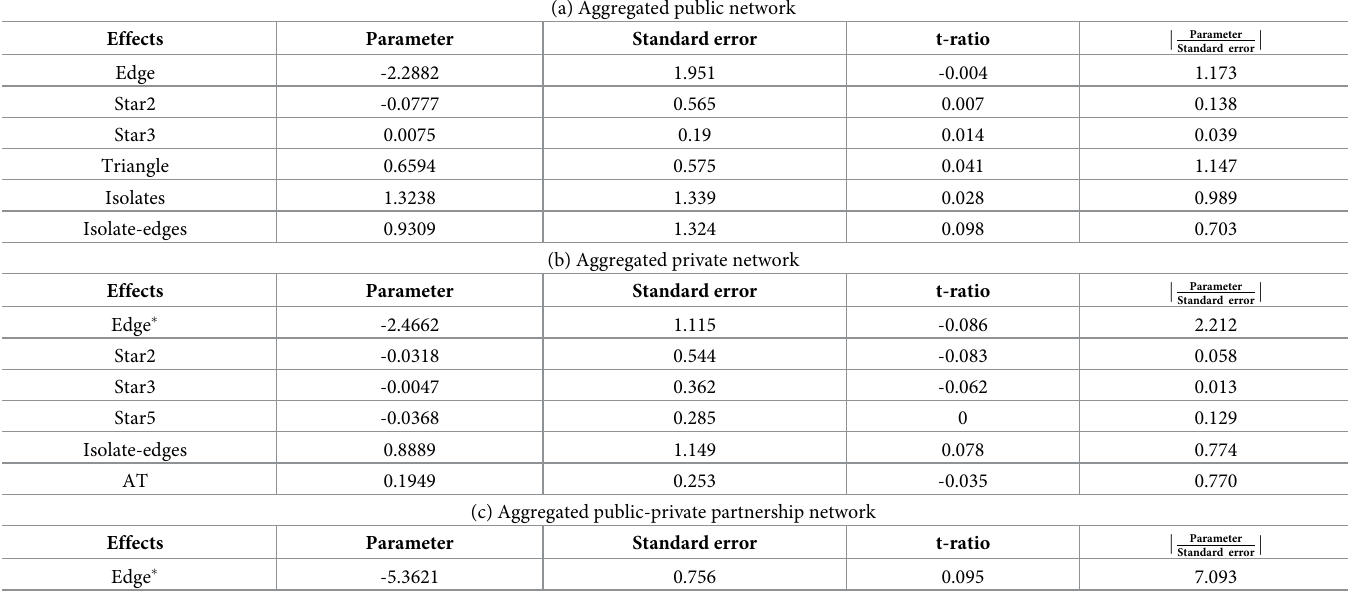
Table 6. The estimation results from the exponential random graph model: (a) aggregated public network; and (b) the aggregated private network. The aggregated PPP network does not converge. AT stands for ’ alternative-k-triangles ’. (a) Aggregated public